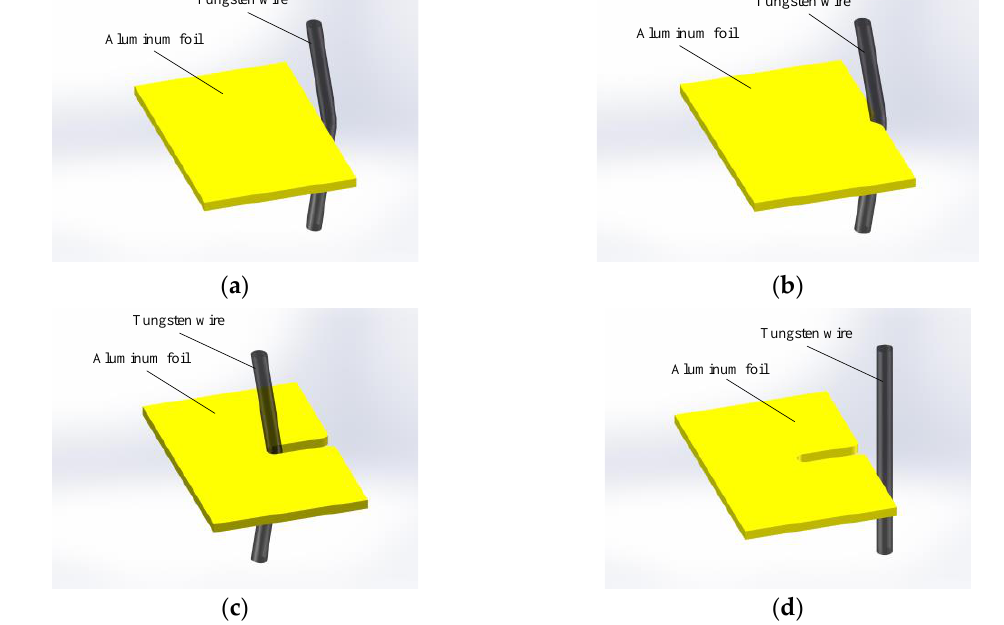
Figure 1. Process of cutting aluminum foil with a tungsten microwire: ( a ) the first step; ( b ) the second step; ( c ) the third step; ( d ) the fourth step.